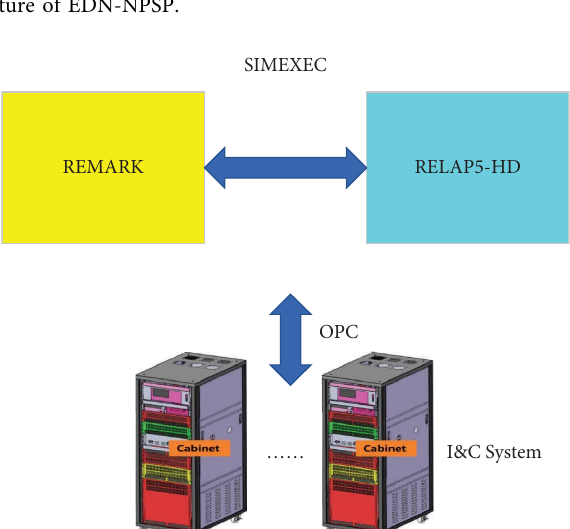
Figure 6: Te architecture of the semiphysical simulation system of